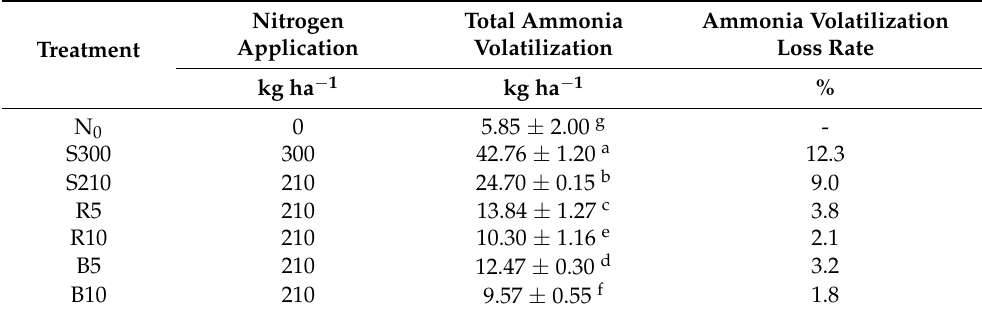
Table 4. Ammonia volatilization loss and ammonia volatilization loss rate with different fertiliza- tion